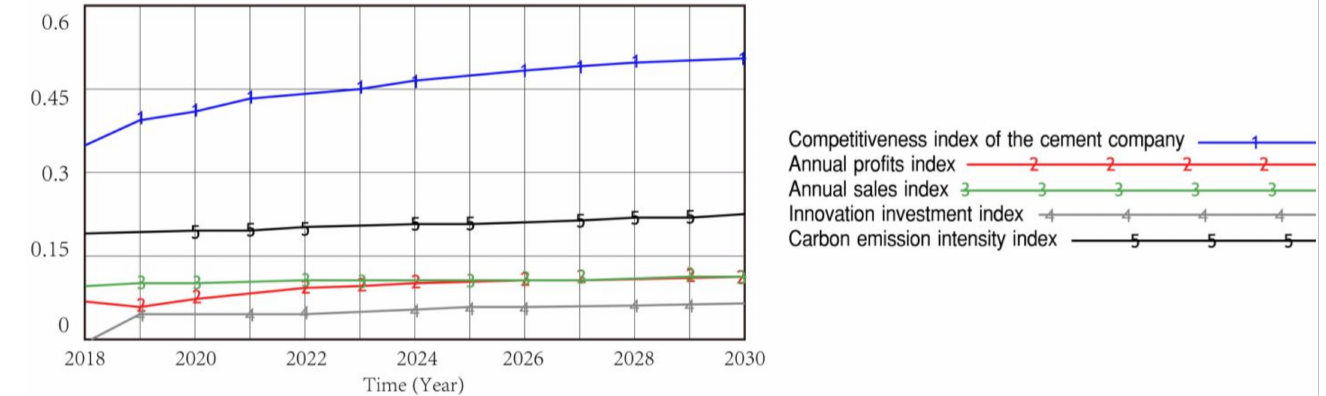
Figure 6. Diagram of competitiveness index of the cement company under the benchmark